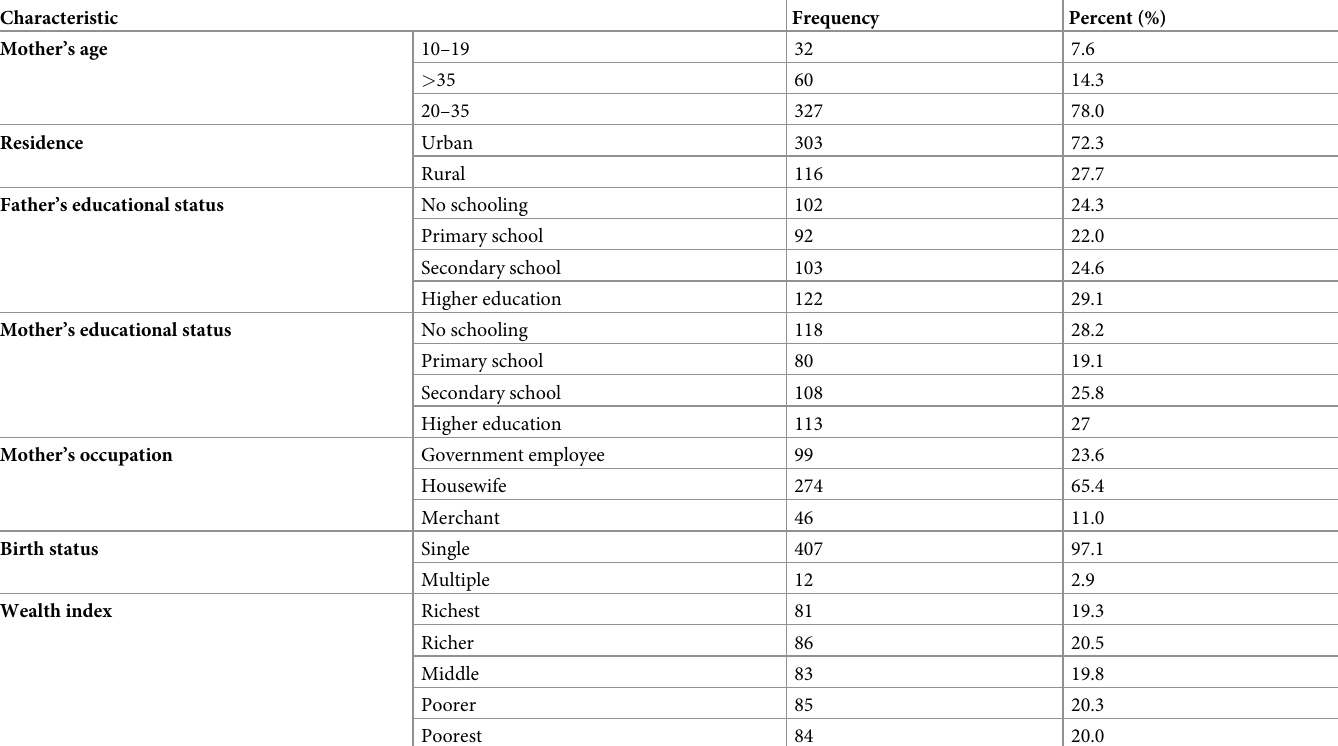
Table 1. Parental and newborn socio-demographic characteristics among newborns delivered at the University of Gondar Comprehensive Specialized Referral Hos- pital, Northwest Ethiopia, 2020.